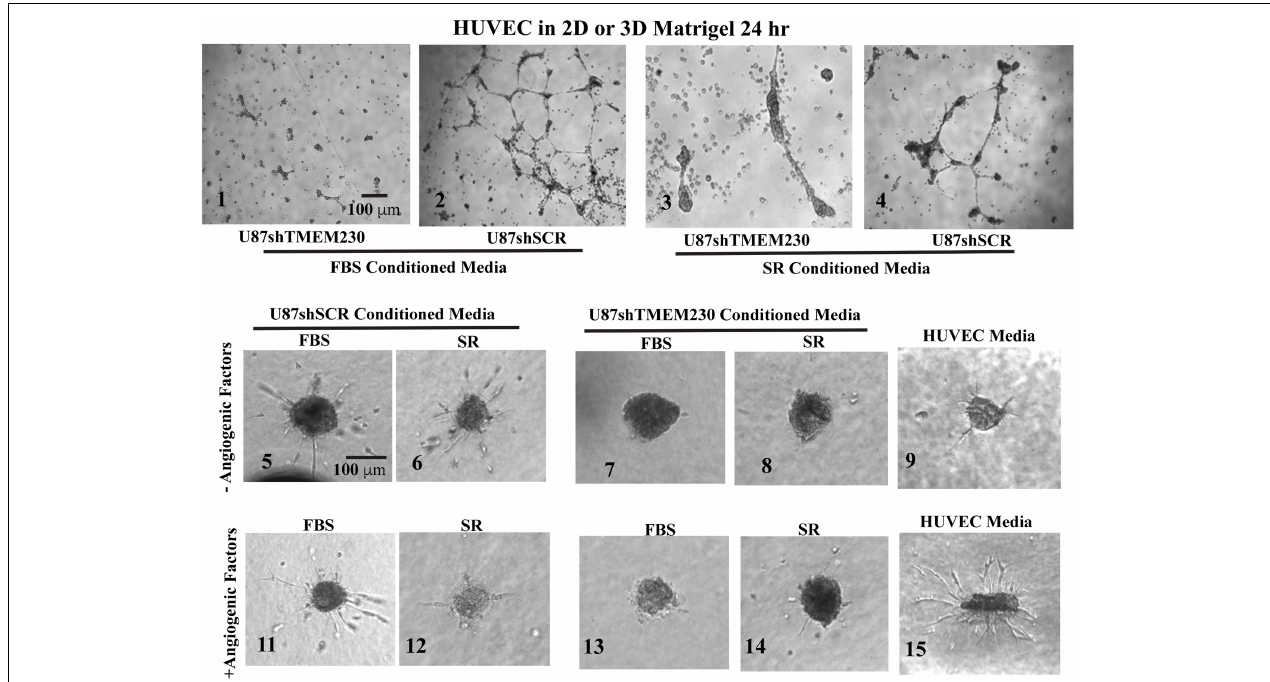
FIGURE 5 | Human umbilical vein endothelial cells cultured in FBS and serum replacement containing conditioned media from U87-MG cells expressing endogenous TMEM230 promoted angiogenic behavior. (1–4) Representative images at 24 h of human umbilical vein endothelial cells (HUVEC) in Matrigel treated with conditioned media obtained from 3 days cultures of U87 control (U87shSCR) and U87 in which TMEM230 was down regulated (U87shTMEM230). (5–15) Human umbilical vein endothelial cells in 3D treated with conditioned media obtained from 3 days cultures of U87 control and U87 which TMEM230 was down regulated shown for without (5–9) and with angiogenic factors (11–14) . U87 cells were cultured in media containing fetal bovine serum (FBS) or serum replacement (SR).